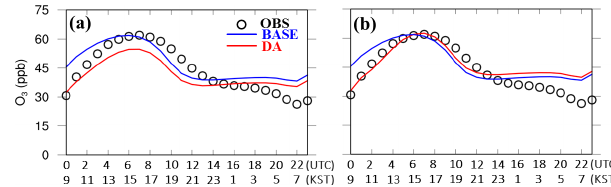
Figure 7. Comparison of CMAQ-simulated O 3 mixing ratios (BASE RUN with blue lines and DA RUN with red lines) with O 3 mixing ratios from Air Korea stations (open black circles). DA RUN was carried out by assimilating CMAQ outputs with Air Korea ob- servations using (a) only O 3 mixing ratios and (b) both O 3 and NO 2 mixing ratios.